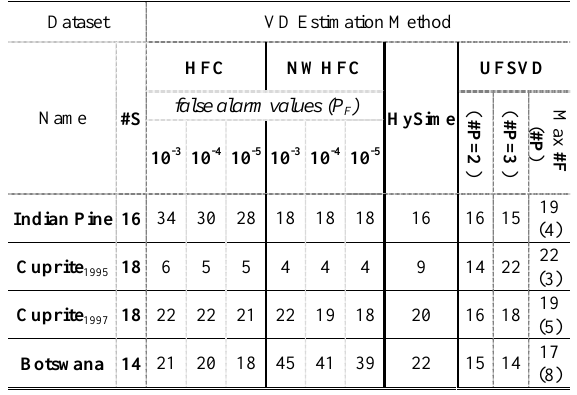
Table 2. The VDs estimated by HFC, NWHFC, HySime and UFSVD for the real datasets. { #S : Number of Signal sources ( i.e. , Substances /Classes), #P : Number of dataset Partitions, #F : Number of selected